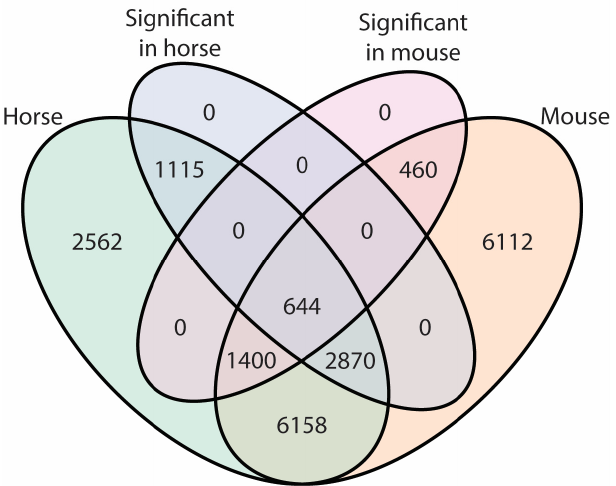
Figure 3. A Venn diagram representing the number of genes expressed in the equine total RNA-seq, murine single-cell RNA-seq, and the amount of statistically significantly differ- initially expressed genes in each of them.